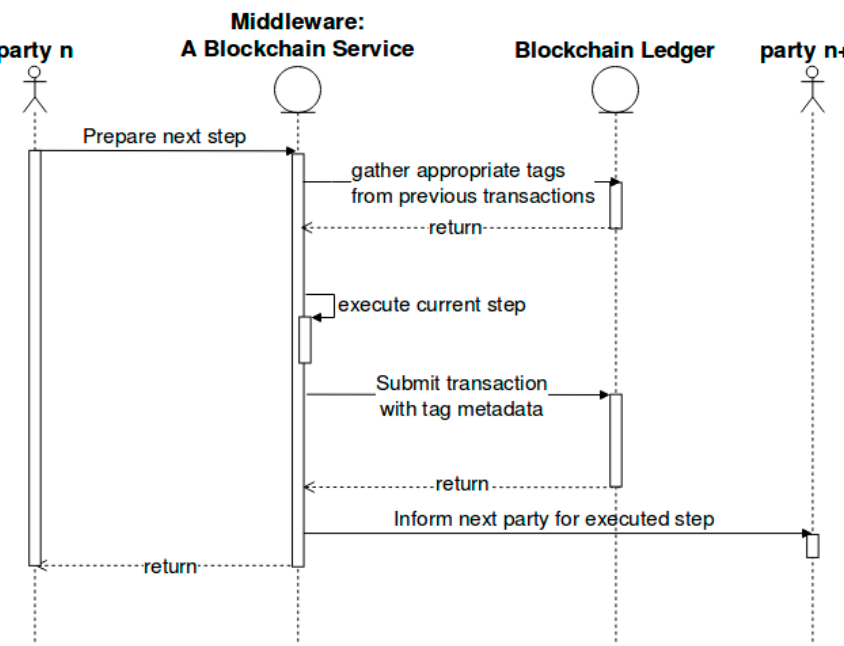
Figure 2. One supply chain freight stage ( stage number n+1 ) as a blockchain transaction. Every stage's functionality is automated by the "Middleware", and thus, the parties that participate in each stage (a single one in the input and another one in the output) have a small interaction with it; for instance, the driver confirms that the transportation was completed by receiving the appropriate transaction hash, or the employee confirms that certain materials were kept refrigerated, as expected, by collecting the corresponding transaction hashes and others. Here, party n participates in stage n +1 input (and already in stage n output) while party n +1 participates on stage n +1 output (and stage n+2